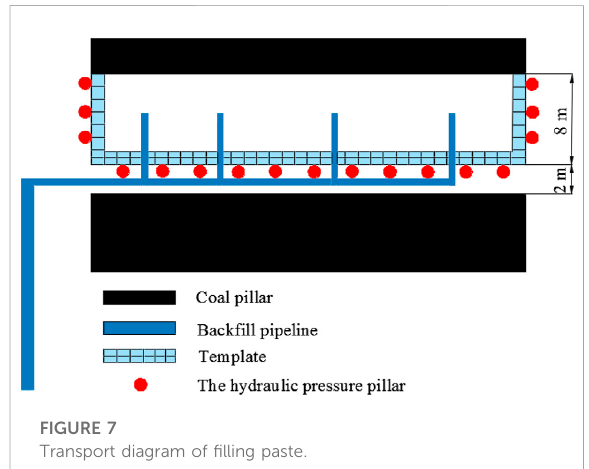
FIGURE 7 Transport diagram of fi lling